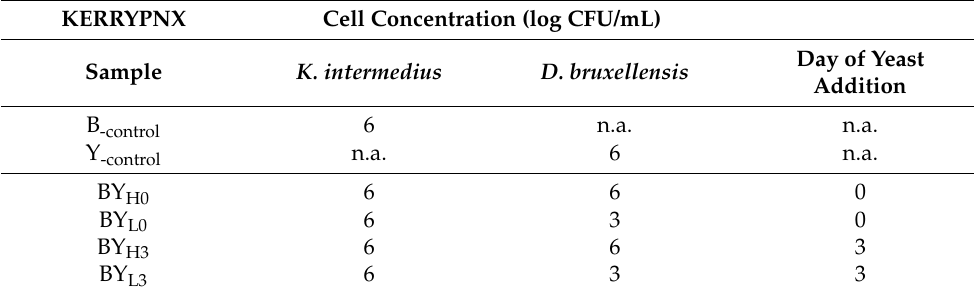
Table 1. BC production experimental set up with K. intermedius mono-(B -control ) and co-cultures with D. bruxellensis at 30 ◦ C. D. bruxellensis was added simultaneously at concentrations of 10 6 CFU/mL (BY H0 ) and 10 3 CFU/mL (BY L0 ) and sequentially at 10 6 CFU/mL (BY H3 ) and 10 3 CFU/mL (BY L3 ). KERRYPNX Cell Concentration (log CFU/mL) Day of Yeast Sample K. intermedius D. bruxellensis Addition B -control 6 n.a. n.a. Y -control n.a. 6 n.a. BY H0 6 6 0 BY L0 6 3 0 6 6 3 6 3